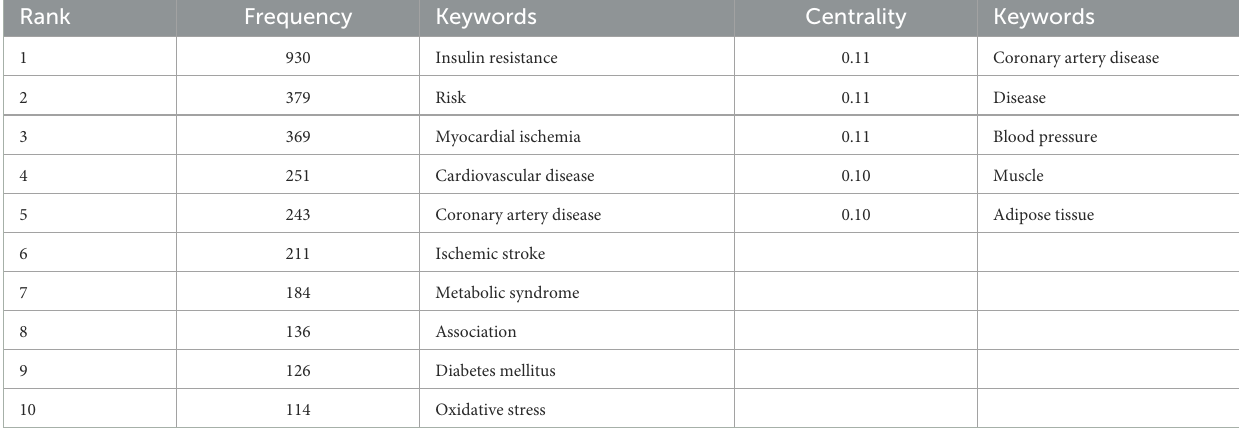
TABLE 5 Top 10 keywords in frequency and top 5 keywords in centrality on insulin resistance and ischemic cerebrovascular disease. Rank Frequency